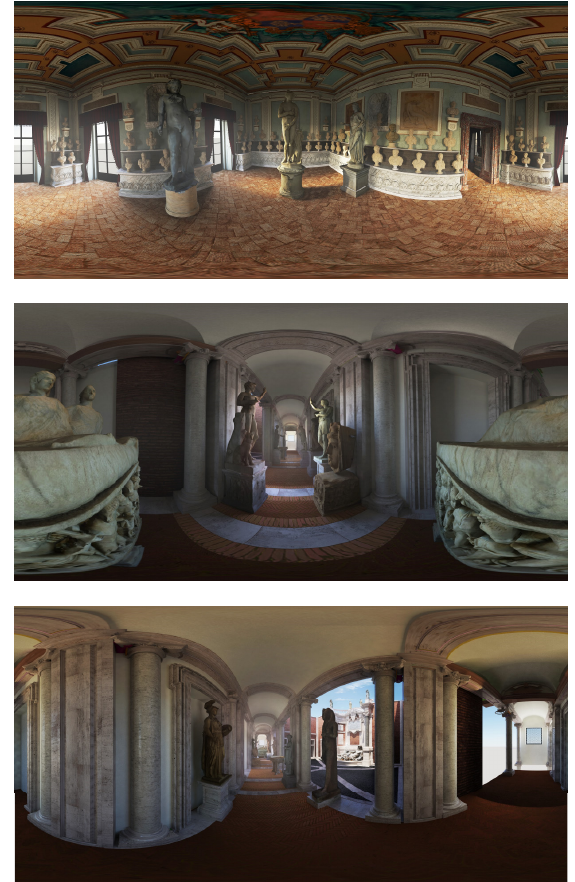
Figure 7. Examples of the 360° renders: (a) the Emperors’ room; (b-c) the Atrium taken from two different views.